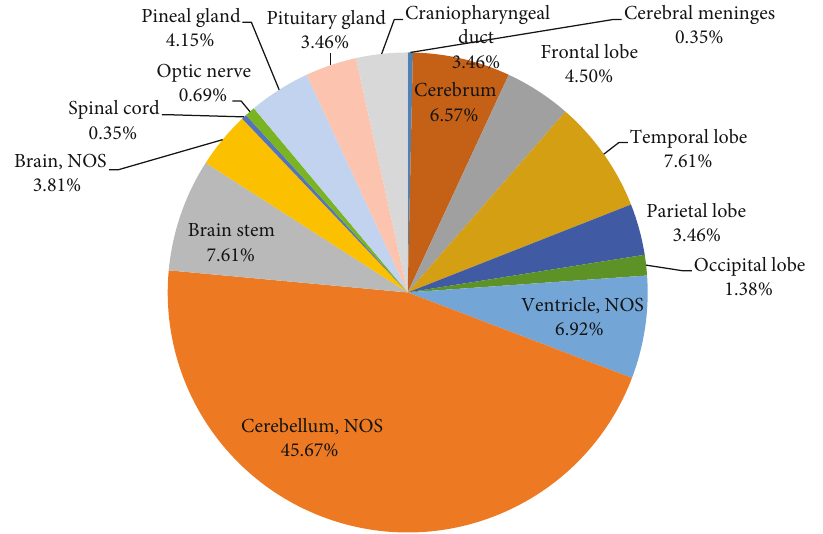
Figure 7: Distribution of all primary CNS tumors by anatomic site for children and adolescents (0-18